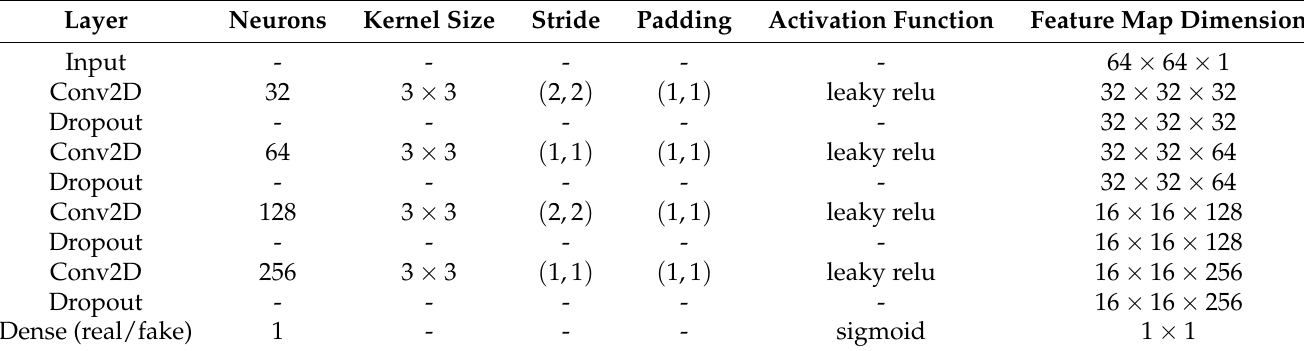
Table 4. Discriminator of the TransfGAN.